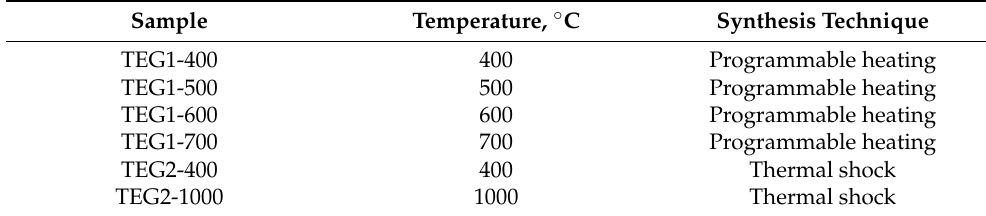
Table 1. Samples synthesized under different